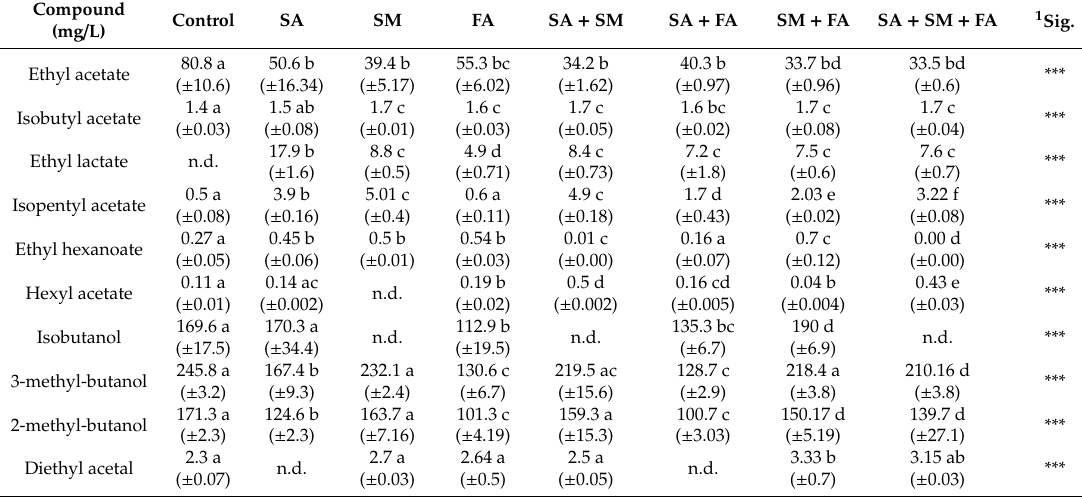
Table 9. Volatile compounds in ciders fermented by distiller’s yeast (G), with the following additions: SA—ammonium sulfate, SM—magnesium sulfate, FA—ammonium phosphate.